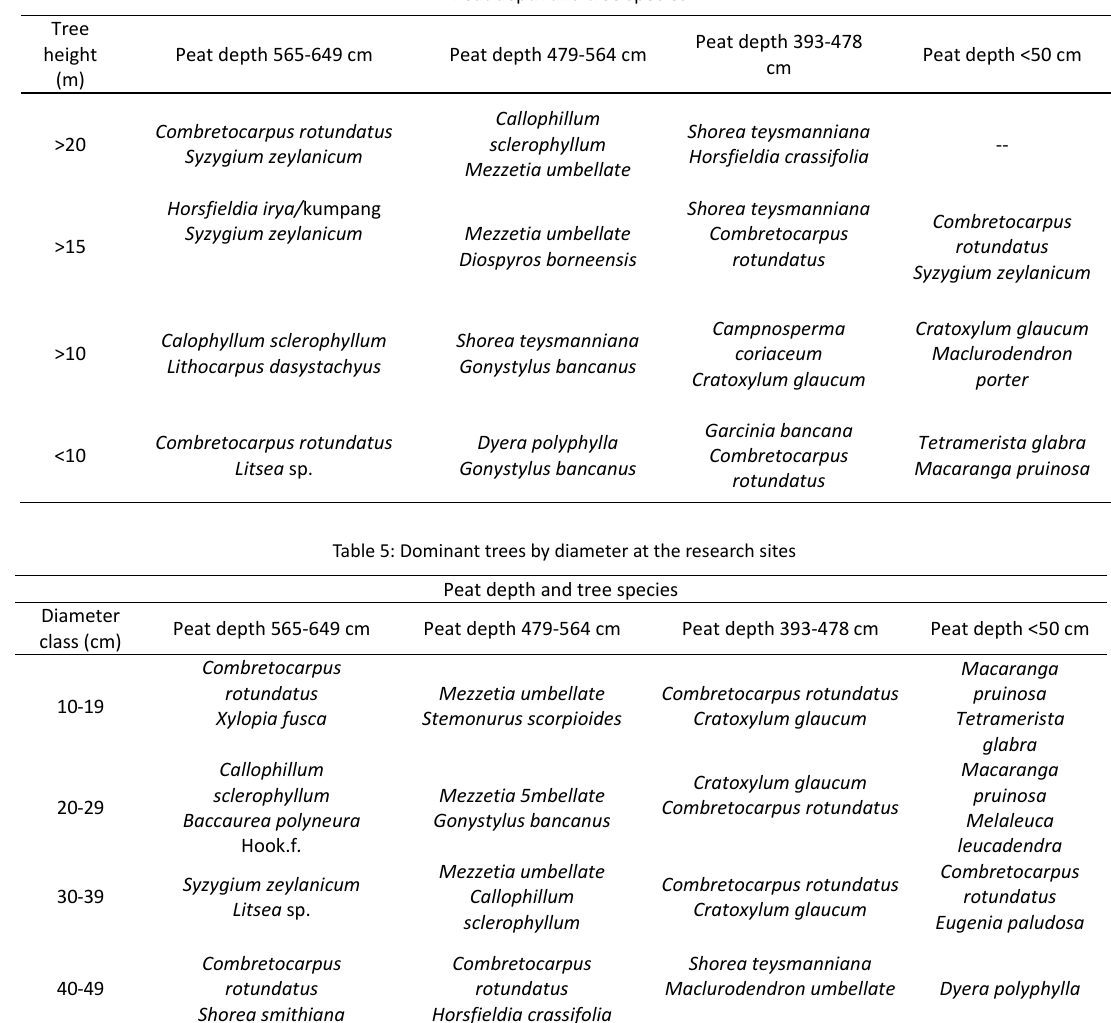
Table 4: Dominant trees by height at the research sites Peat depth and tree species